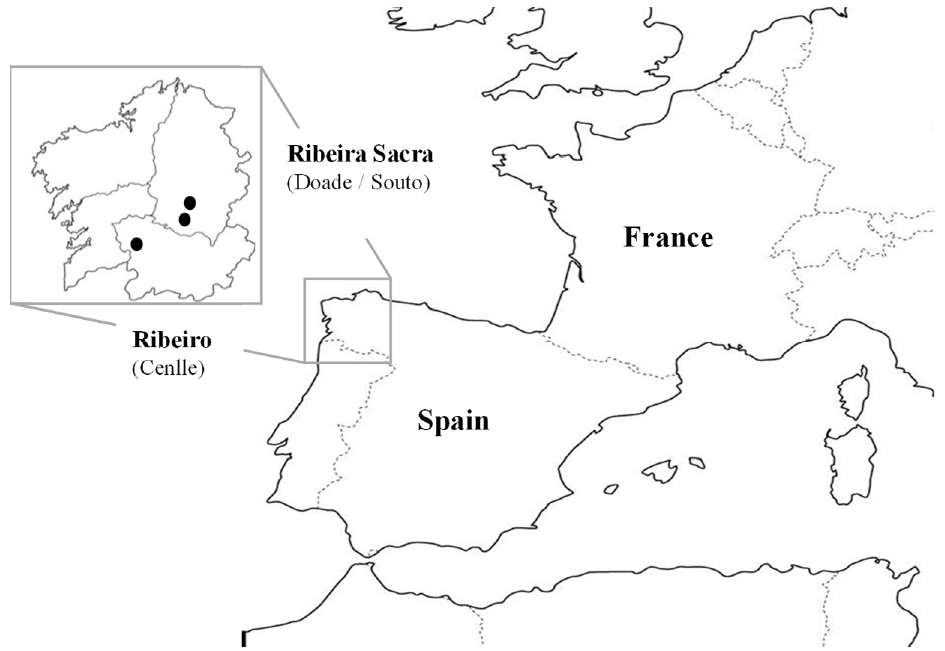
Figure 1. Location of the Ribeiro (Cenlle vineyard) and Ribeira Sacra (Doade and Souto vineyards) winegrowing Designation of Origin